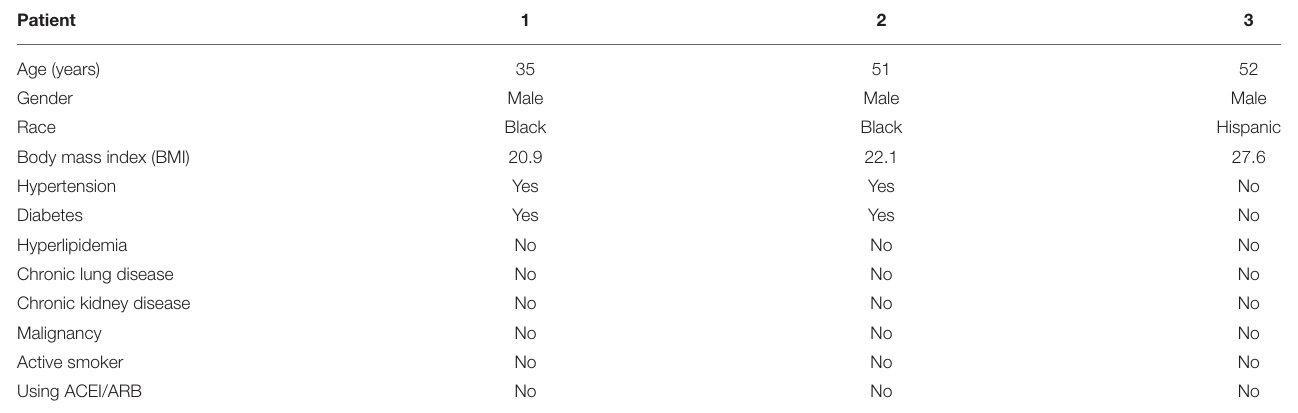
TABLE 1 | Clinical characteristics of three patients on